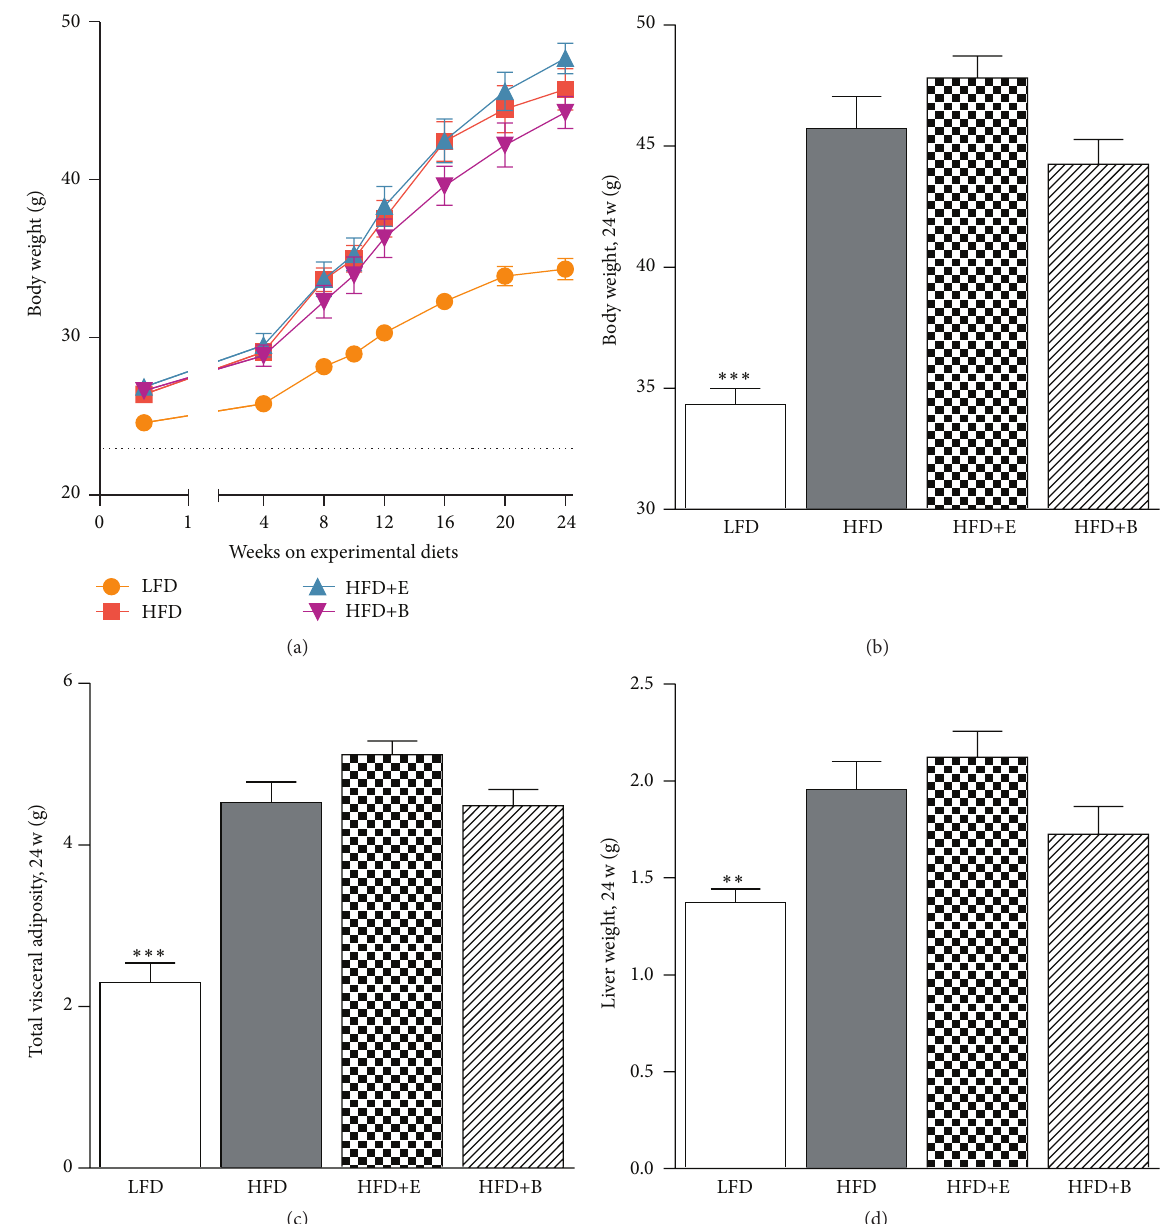
Figure 1: Body and organ weights. Polyphenol supplementation does not attenuate HFD-induced obesity (baseline 22.95 ± 0.18 ) (a-b), total weight of visceral adipose depot (c), or total liver weight. Dotted line depicts baseline value. Significant ( 𝑝 < 0.05 ) from HFD ( ∗∗ 𝑝 < 0.01 , ∗∗∗ 𝑝 < 0.001